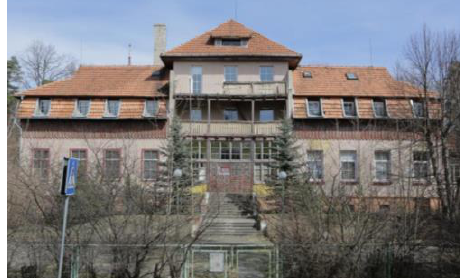
Figure 2. Western façade view of Luise sanatorium building